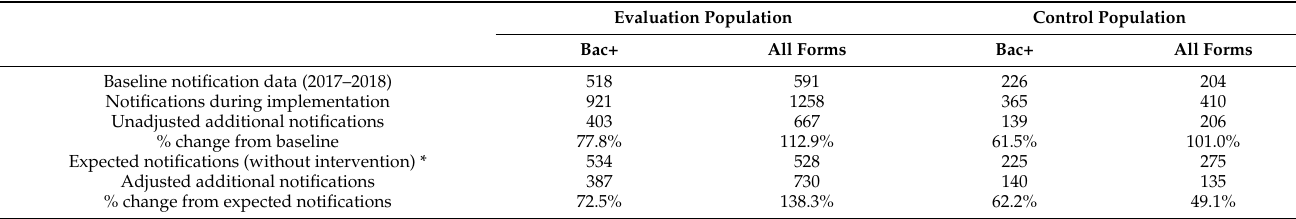
Table 2. Additional TB case notifications compared to baseline and expected notifications in the evaluation and control populations.